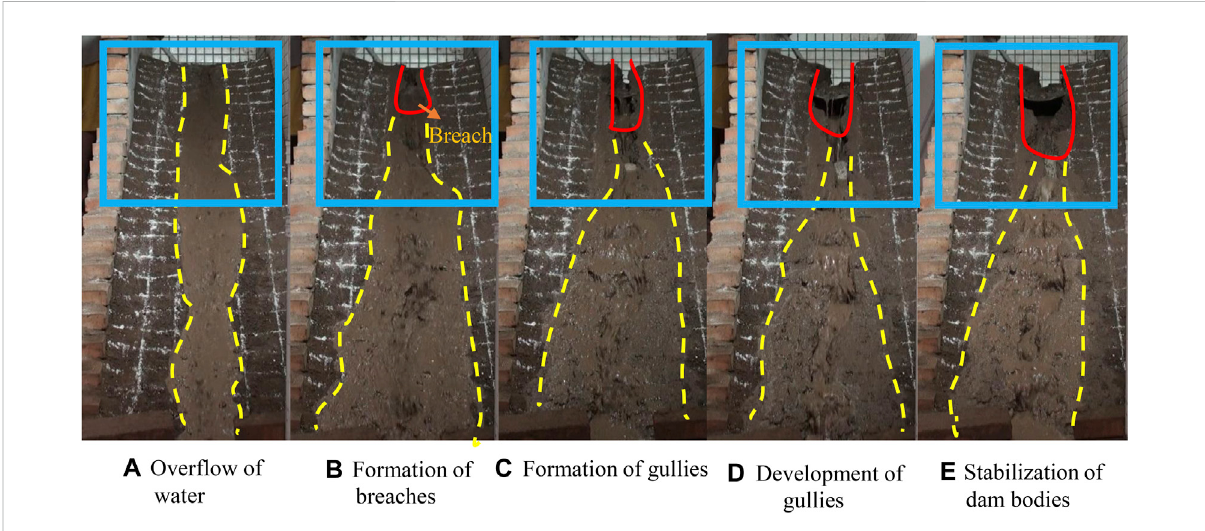
FIGURE 7 The overtopping process of reinforced tailings. (A) Over fl ow of water; (B) Formation of breaches; (C) Formation of gullies; (D) Development of gullies; (E) Stabilization of dam bodies.